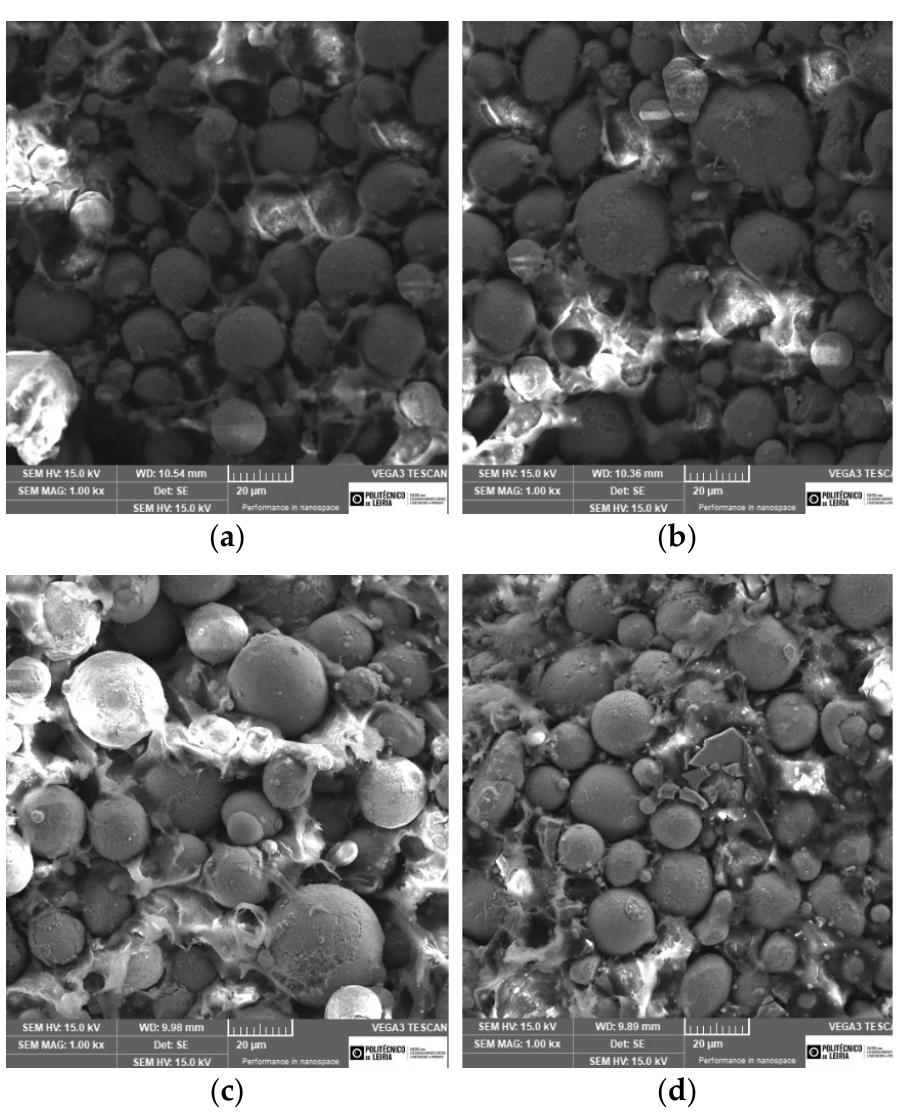
Figure 3. Micrographies of the green filaments (SEM), ( a ) A, ( b ) B, ( c ) C, and ( d ) D. In filaments A, B, and C, the particles have a shape factor close to 1. However, in filament D (Ni addition), some sharpened particles are observed.